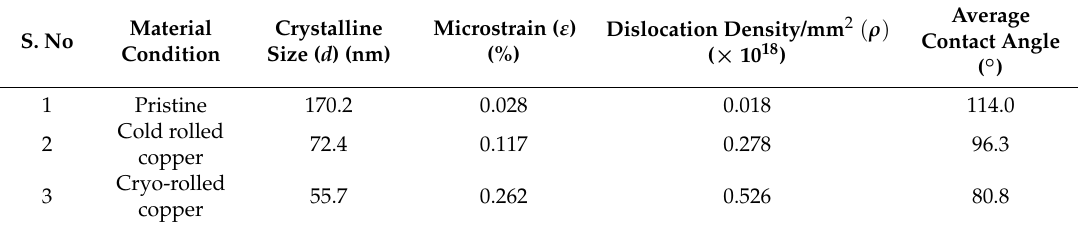
Table 1. Structural properties of the three copper